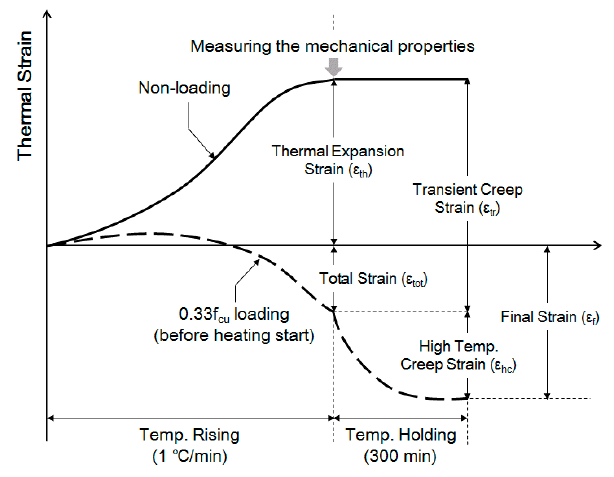
Figure 4. Evaluation of the strain properties of concrete [10].